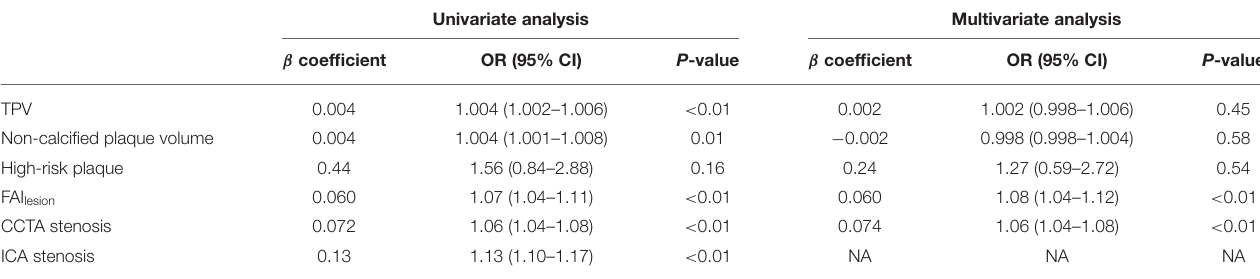
TABLE 3 | Univariate and multivariate analysis for the prediction of functional ischemia.